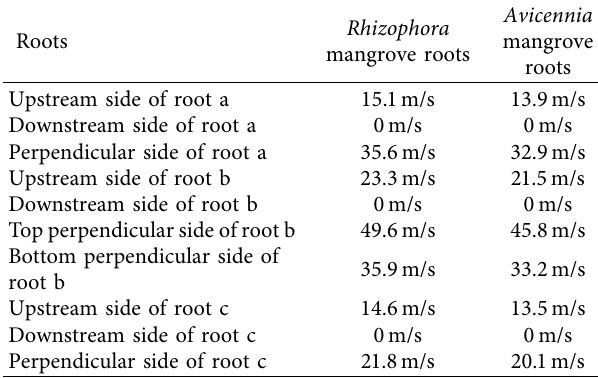
Table 3: Comparison of velocity of 3 different roots at different positions of incompressible unsteady air flow within 12